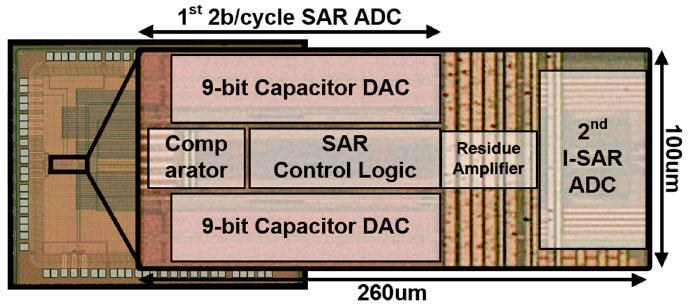
Figure 15. Die photograph. Reprinted with permission from Ref. [22]. Copyright 2019 the Japan Society of Applied Physics.